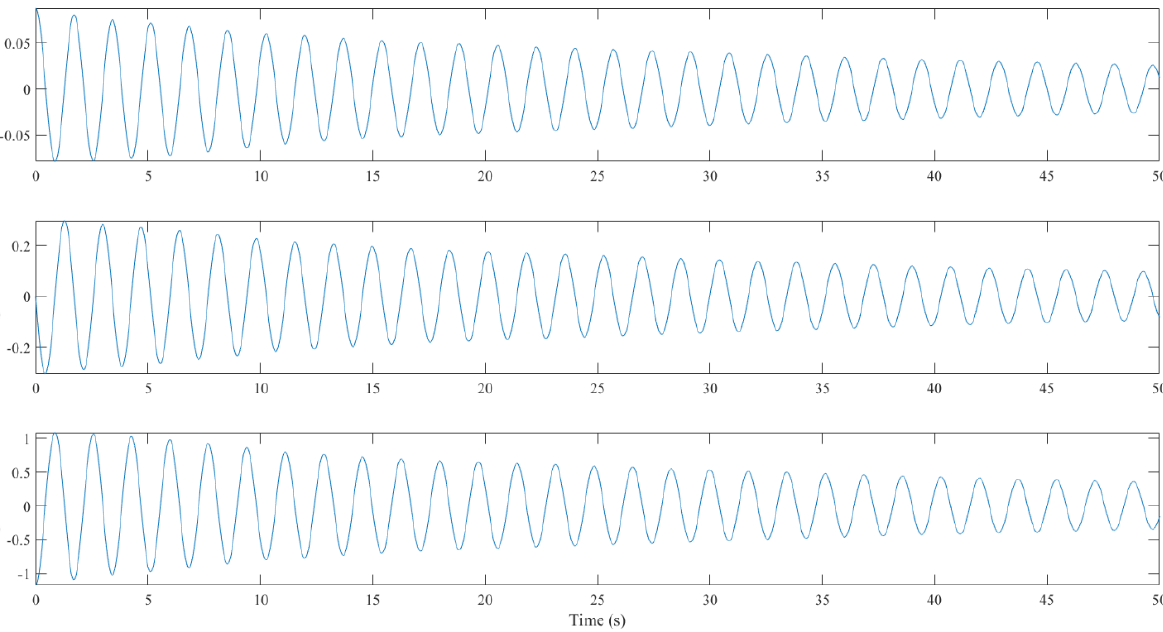
Figure 4. The vertical displacement, velocity, and acceleration time histories of the floating body under free vibration at an initial 5° pitch.